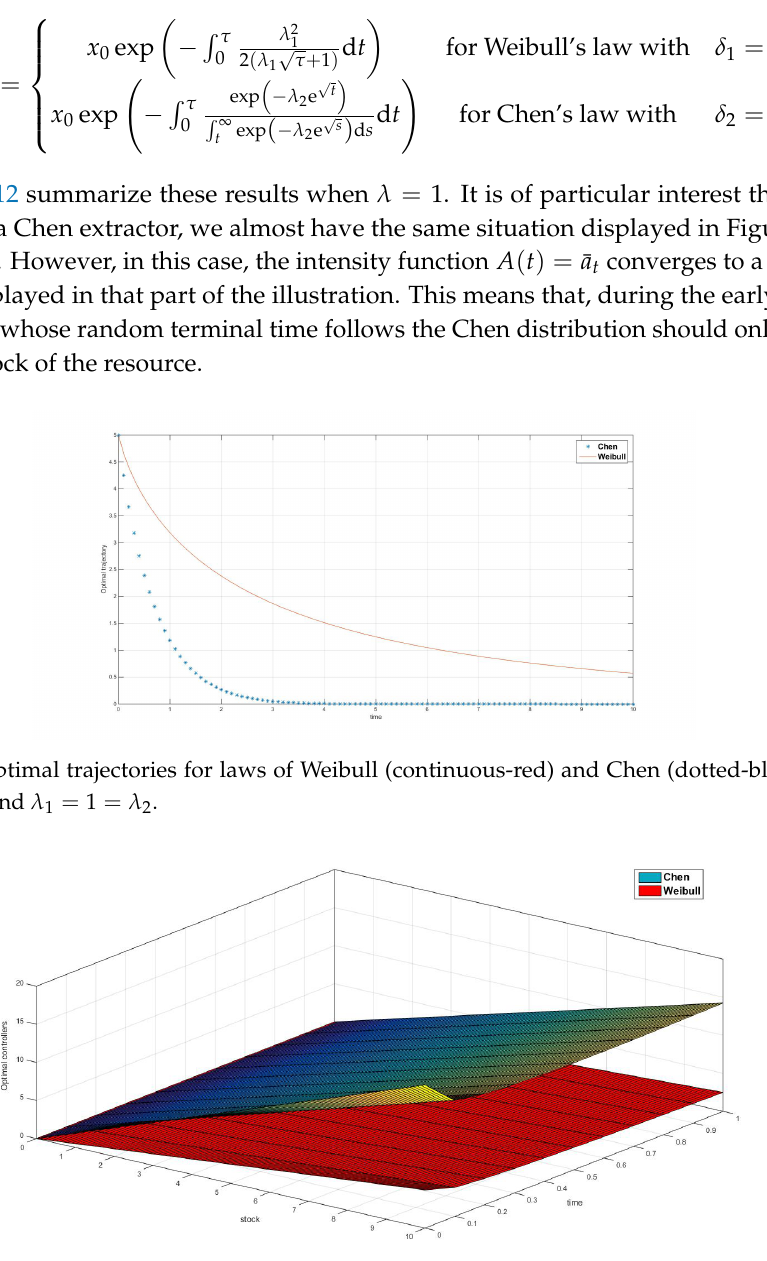
= δ = 1 = λ 2 and λ 1 2 for 2